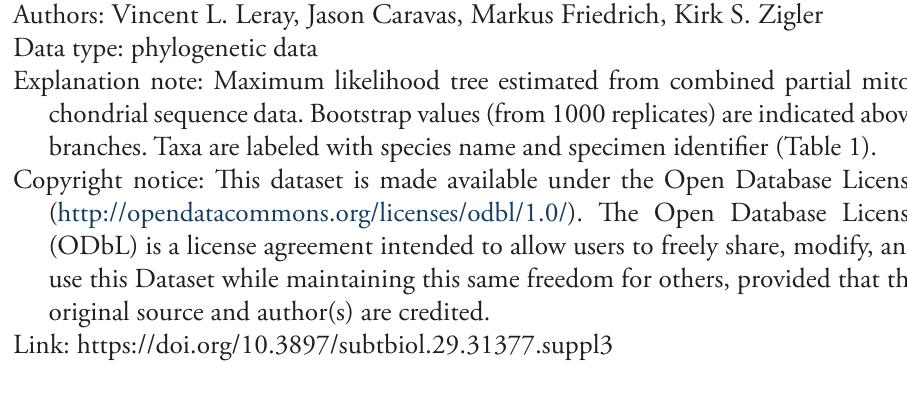
Figure S1. Maximum likelihood majority rule consensus bootstrap